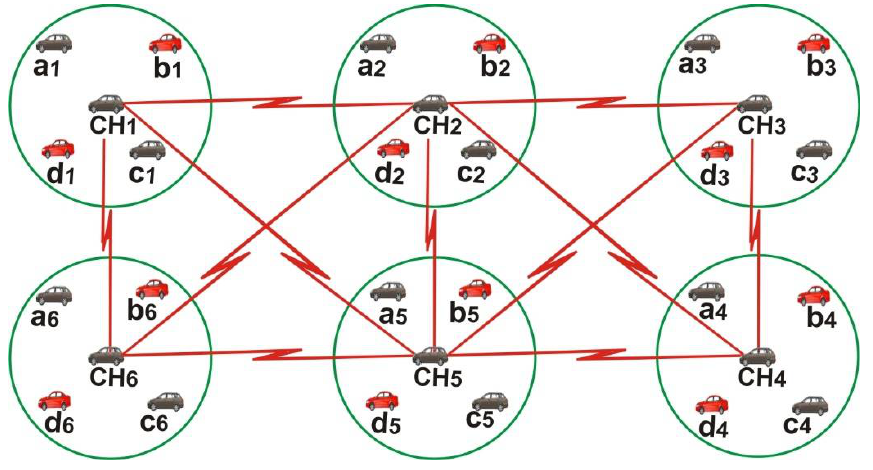
Figure 1. Merging cluster structure.